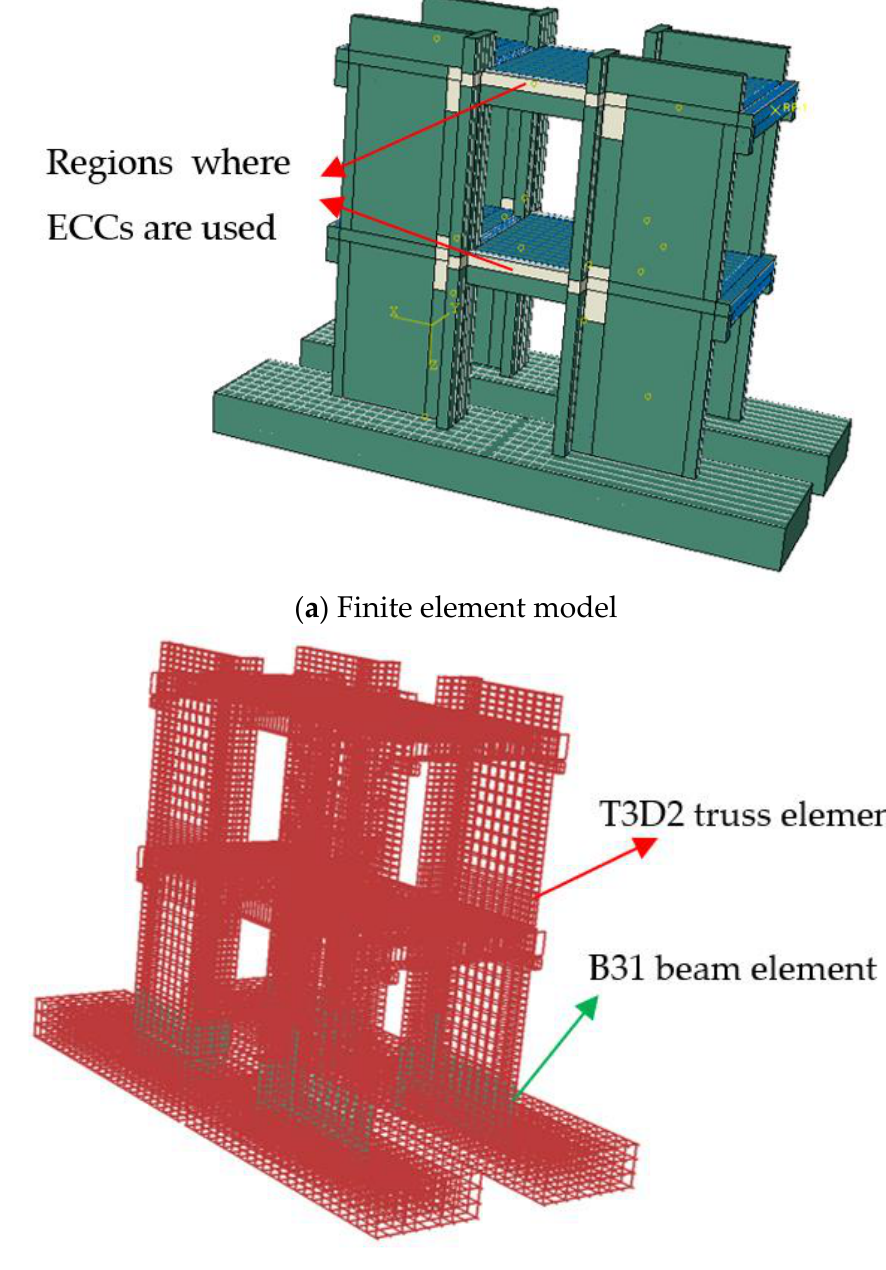
Figure 2. Finite element analysis model of the 1/2-scale two-story spatial structure specimen of the prefabricated ECC/RC combined shear wall.